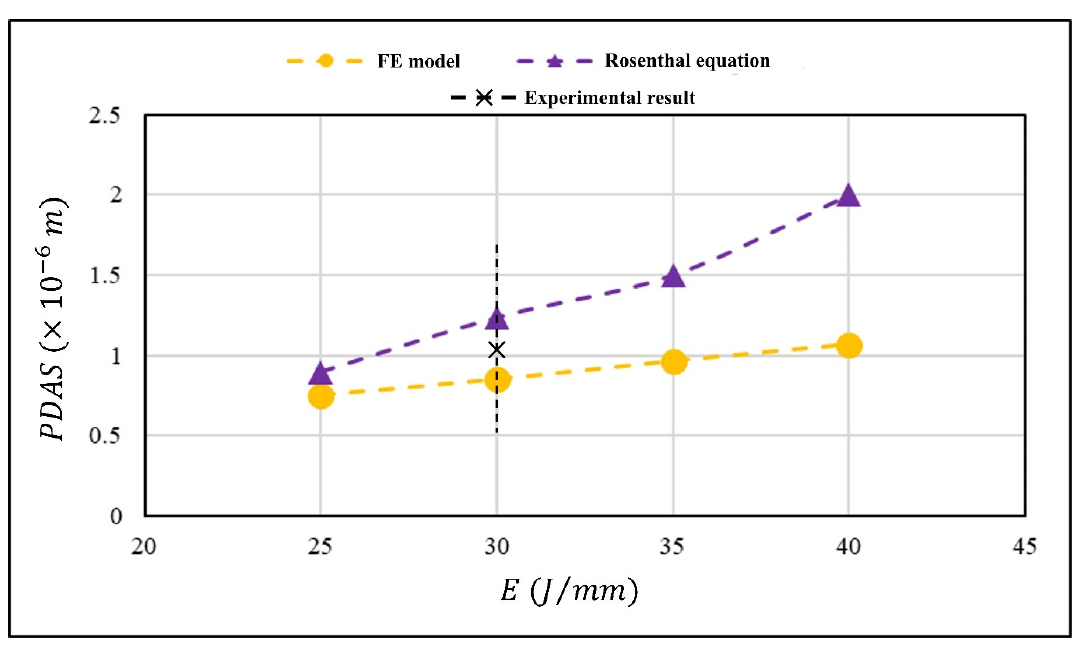
Figure 10. Variation of primary dendrite arm spacing (PDAS) obtained from the experiment, the numerical modeling, and the analytical method versus heat input.